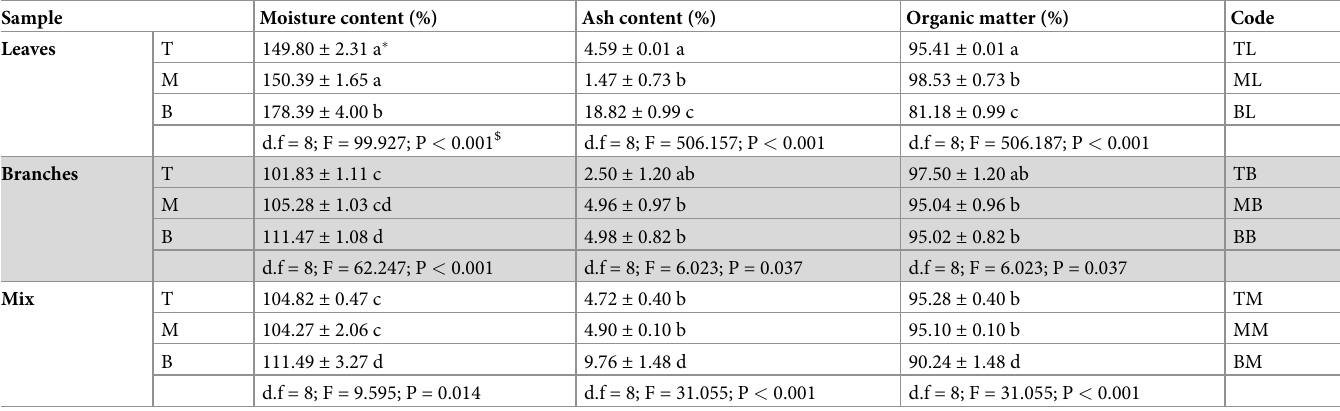
Table 1. Comparison of the physicochemical indexes at different decomposition stages of fungus-combs.